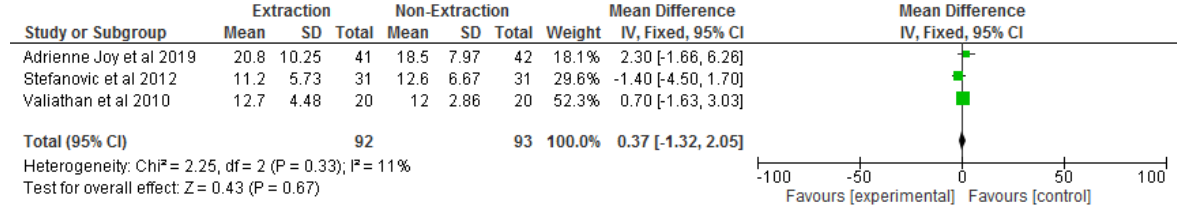
Figure 13. Funnel plot for Surgery class III between pre and post surgery.